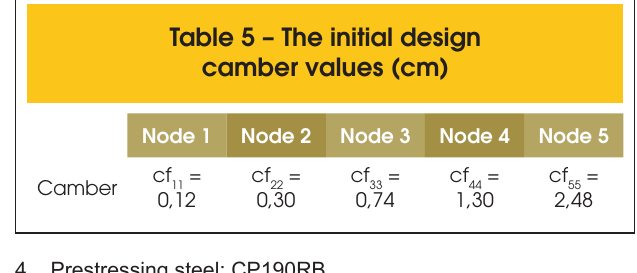
Table 5 – The initial design